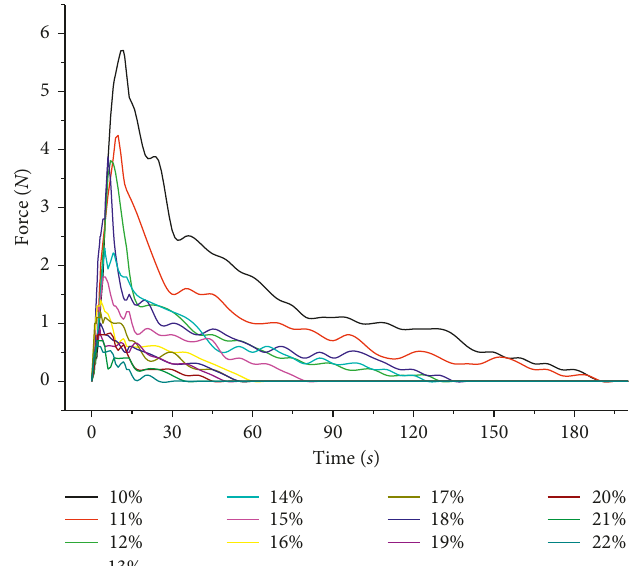
Figure 16: Results of pull-out